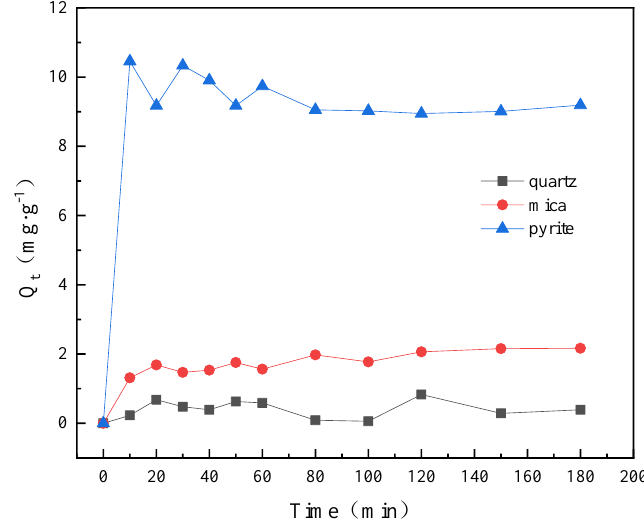
Figure 1. Effect of time on the adsorption of thiourea on quartz, mica, and pyrite.